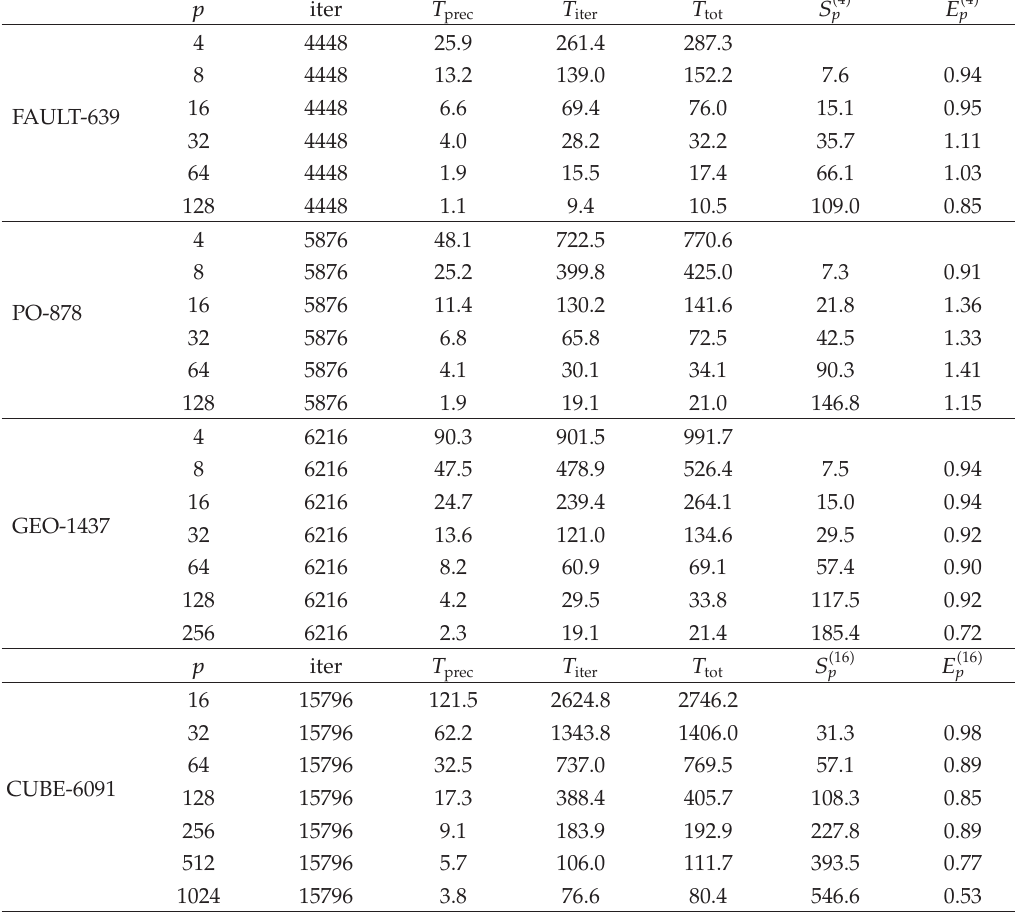
Table 2: Number of iterations, timings, and scalability indices for FSAI-DACG in the computation of the 10 leftmost eigenpairs of the four test